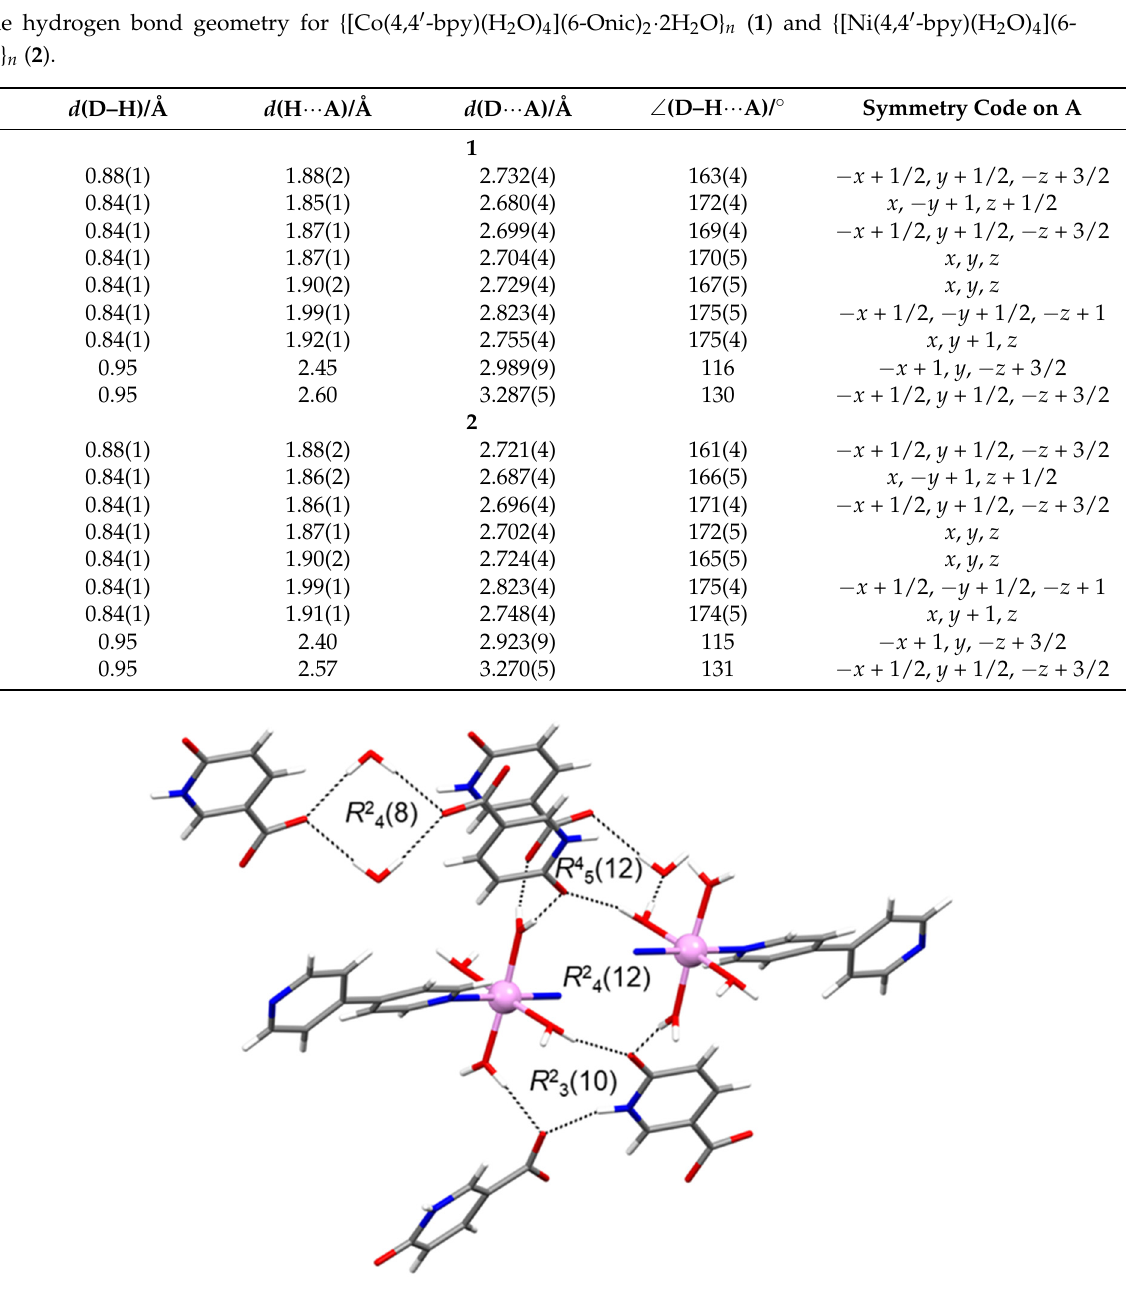
Figure 3. The most distinguished hydrogen-bonded ring motifs (shown by dotted lines) found within the hydrogen-bonded framework of {[Co(4,4 ′ -bpy)(H 2 O) 4 ](6-Onic) 2 ·2H 2 O} n ( 1 ), e.g., the trimeric R 2 3 (10) motif, the centrosymmetric tetrameric R 2 4 (8) and R 2 4 (12) motifs and the pentameric R 45 (12) motif.